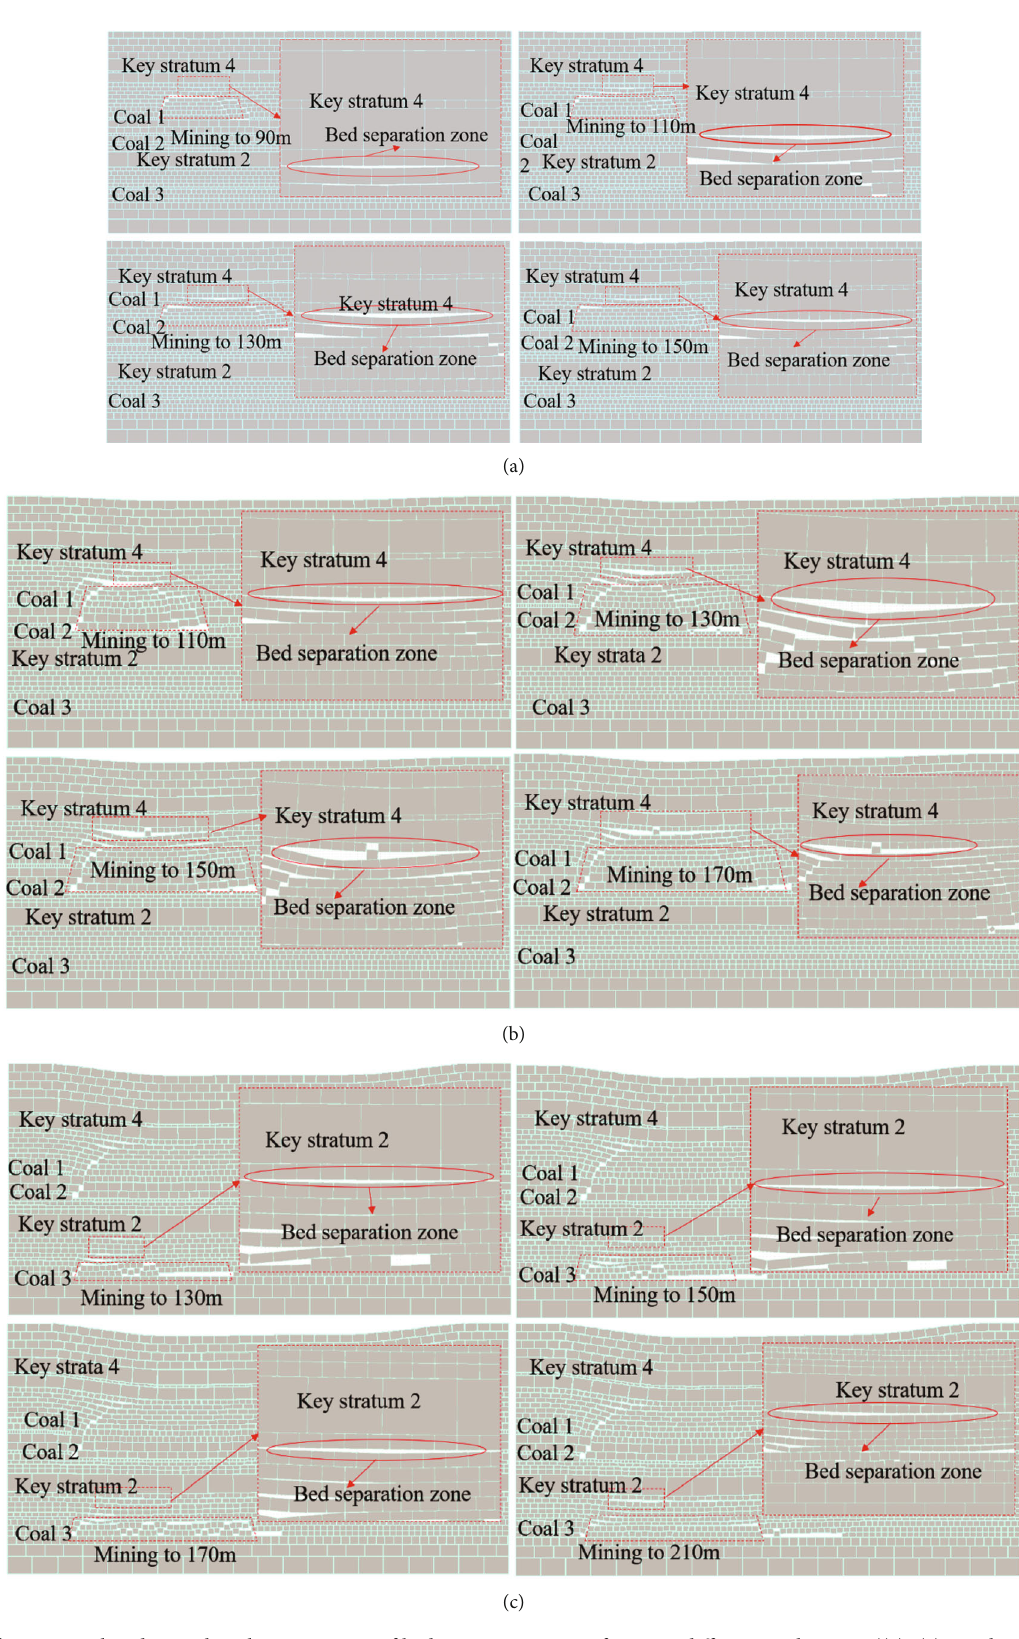
Figure 7: The temporal and spatial evolution pattern of bed separation zone of mining di ff erent coal seams. ((a) – (c) are the temporal and spatial evolution pattern when mining coal 1, coal 2, and coal 3,